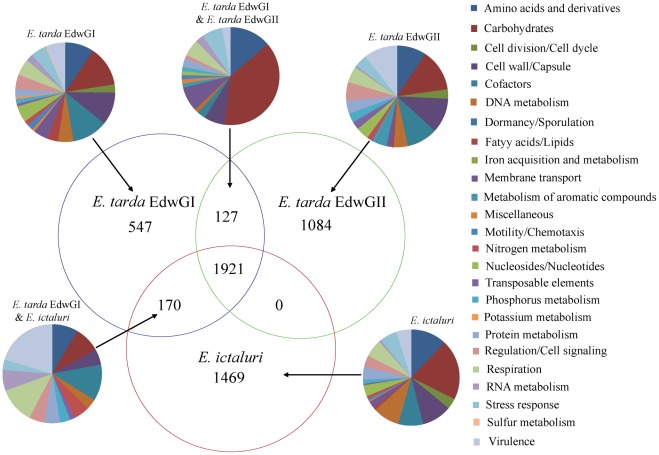
The Venn diagram illustrating the number of genes unique or shared between two Edwardsiella lineages.The associated pie charts showed the functional groups assigned for CDSs in relevant sections of the Venn diagram. The strains used for comparison were E. tarda EIB202, FL6-60, and 080813 in EdwGI lineage, DT, ATCC15947, and ATCC23685 in EdwGII lineage, and E. ictaluri ATCC33202 and 93–146.